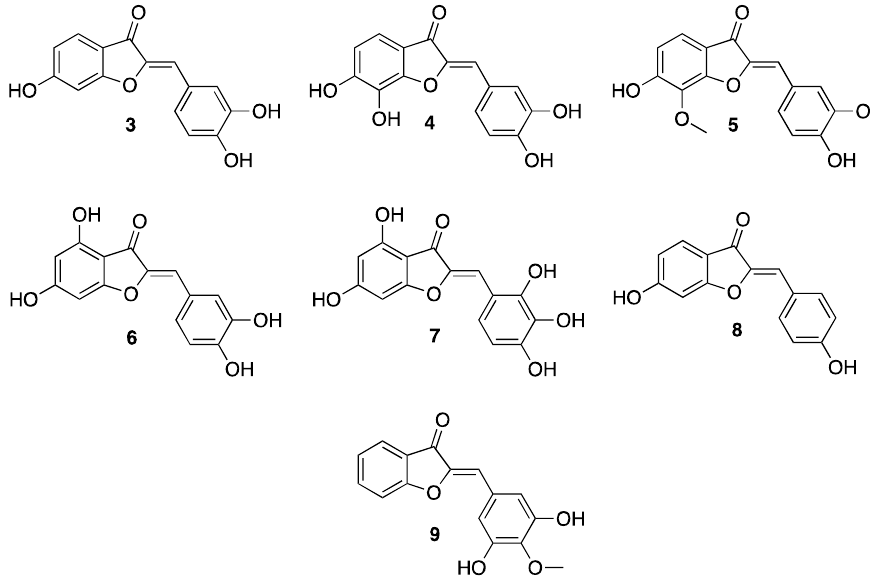
Figure 2. Chemical structures of 4-deoxy- and 4-hydroxy-aurones.